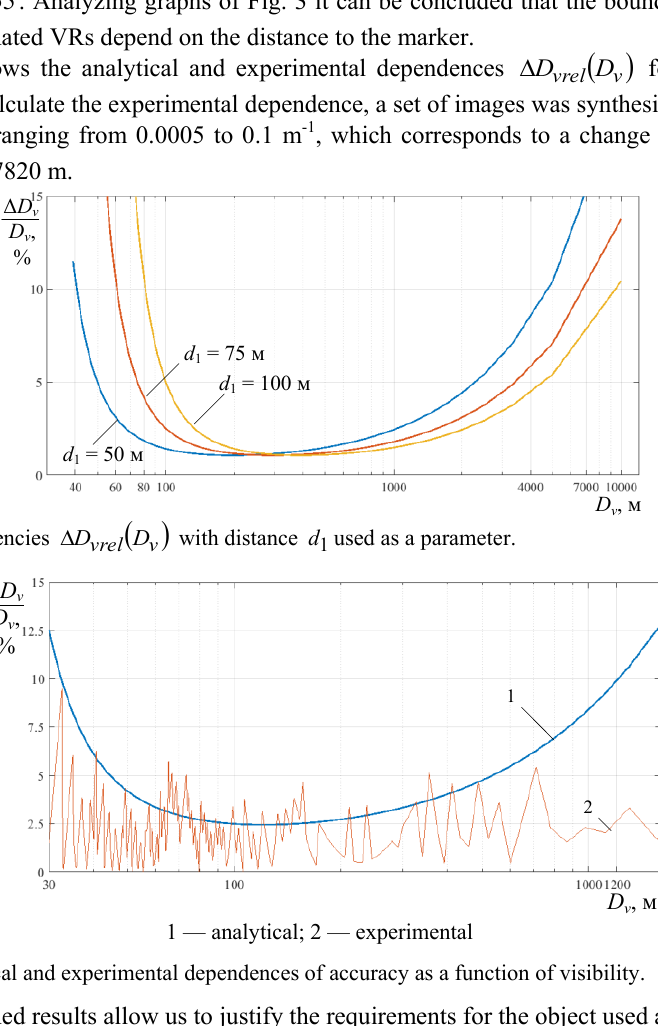
Fig. 4. Analytical and experimental dependences of accuracy as a function of